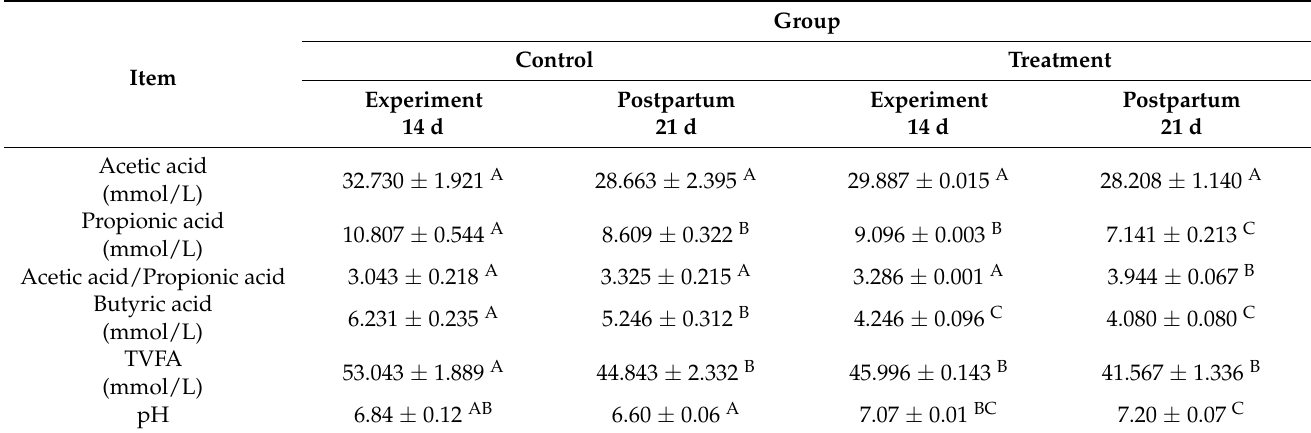
Table 6. The effects of experimental feed on fermentation parameters in rumen of perinatal female goats.